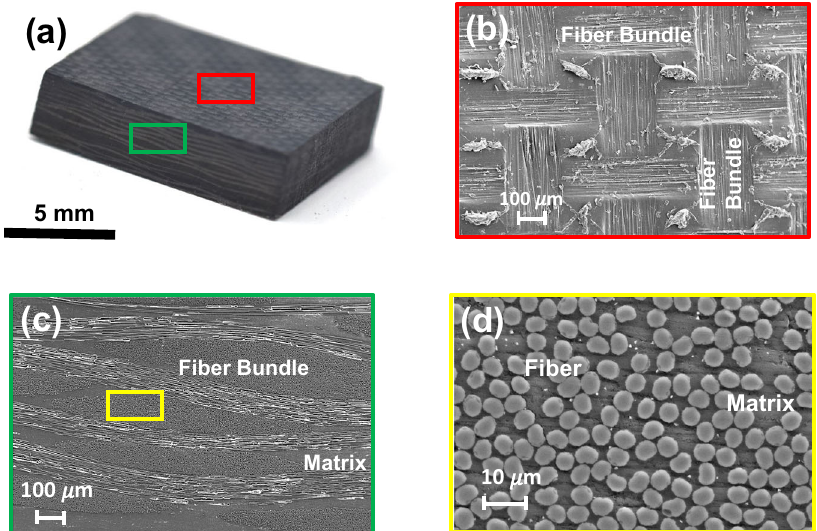
Fig. 1 Optical and scanning electron microscopy (SEM) images of the fabricated polymer composite. a An optical image of a polymer composite sample at the millimeter scale. This composite consists of woven bundles of carbon fi ber with vinyl ester polymer as the binding matrix as shown in b and c , which are SEM images of the top/bottom surface and cross-section of the sample in a . Bio fi lms were collected from both the top and bottom surfaces of the composite material shown in b . d A cross-section SEM image within a fi ber bundle which consists of fi bers and matrix at the